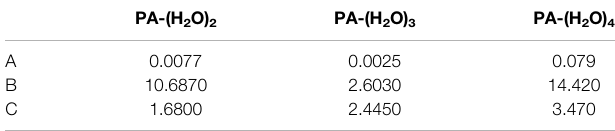
TABLE 4 | Values of coef fi cients A, B, and C in the empirical formula of electron density.